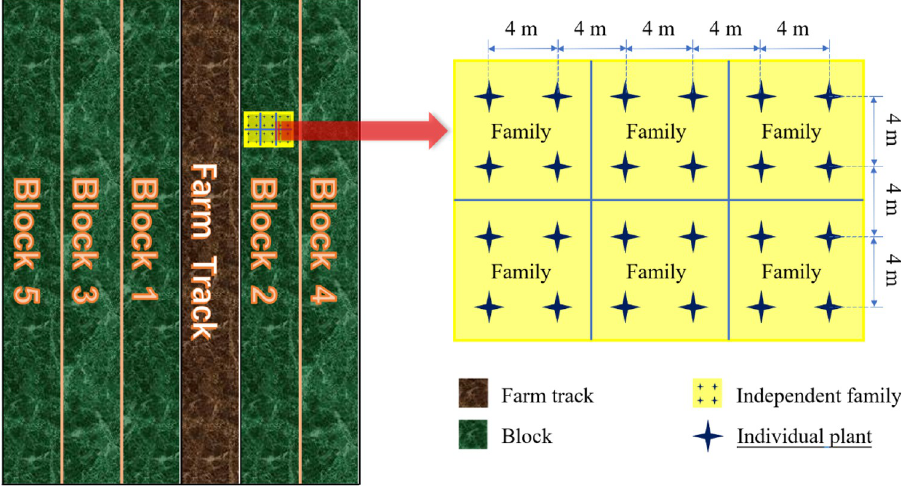
Fig 2. Schematic diagram of test